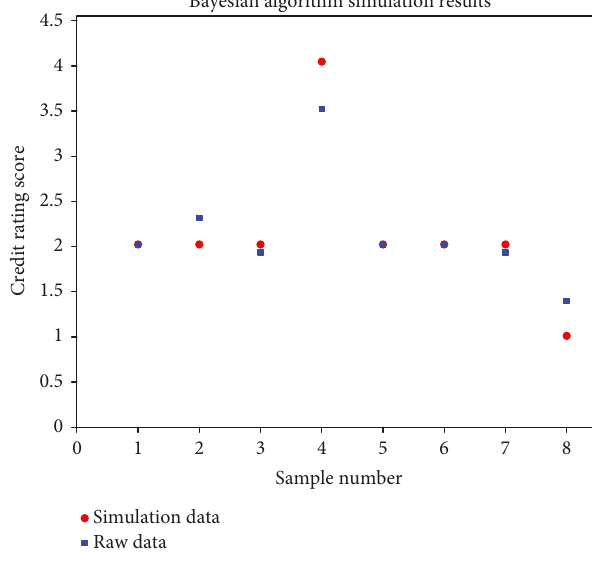
Figure 11: LM test results. Figure